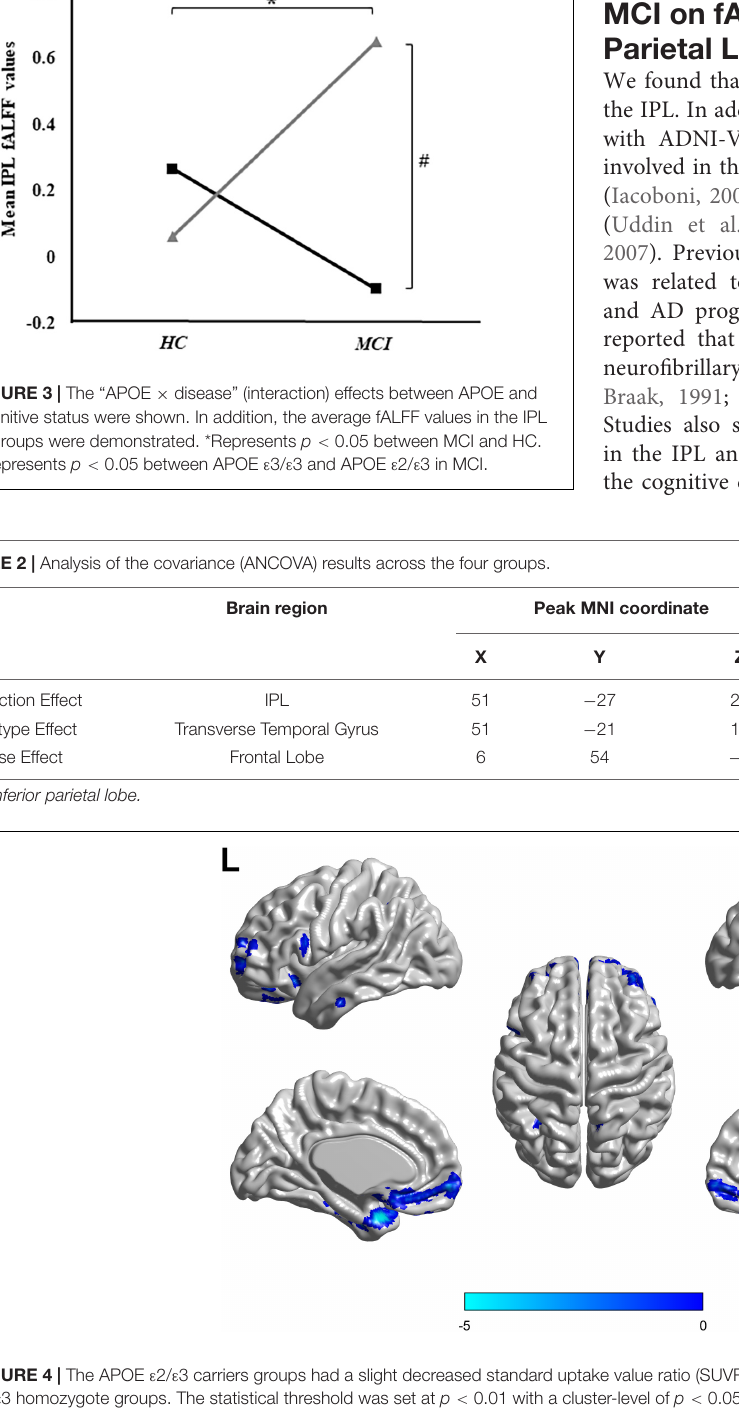
Frontiers in Aging Neuroscience |